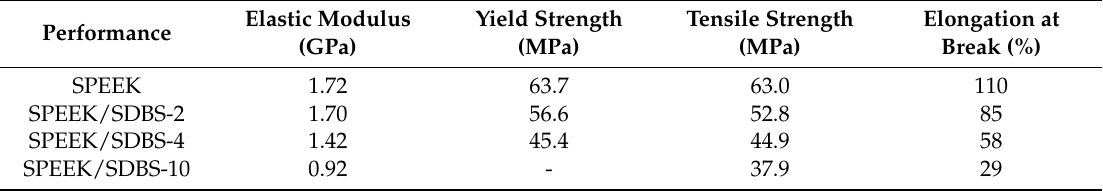
Table 1. Mechanical properties of SPEEK/SDBS